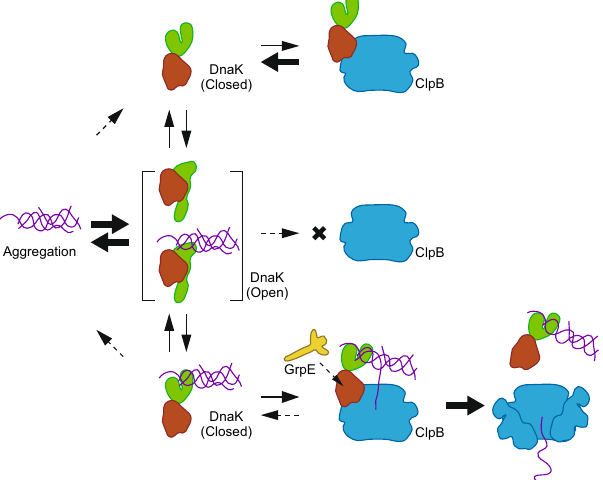
Figure 7. Models for the interactions between chaperones and protein aggregations. DnaK cycles conformational changes between open and closed forms. Although the open form can readily bind and release aggregated proteins, the closed form does not. The closed form of DnaK can bind ClpB and activate it; however, owing to the low affinity, the complex readily dissociates. However, if the bound DnaK holds an aggregation, the ClpB can start threading it. During the threading, the DnaK is tethered by the aggregation to the ClpB and the interaction between NBD and MD of these chaperones is maintained. Consequently, the NBD-MD interaction reduces the approach of GrpE to the DnaK molecule; therefore, the DnaK would maintain the closed form. Thus, the trigonal complex consisting of DnaK, ClpB, and protein aggregation is stabilized. The dissociation of this complex would be effected by accomplishment of the threading and/or collapse of the ClpB